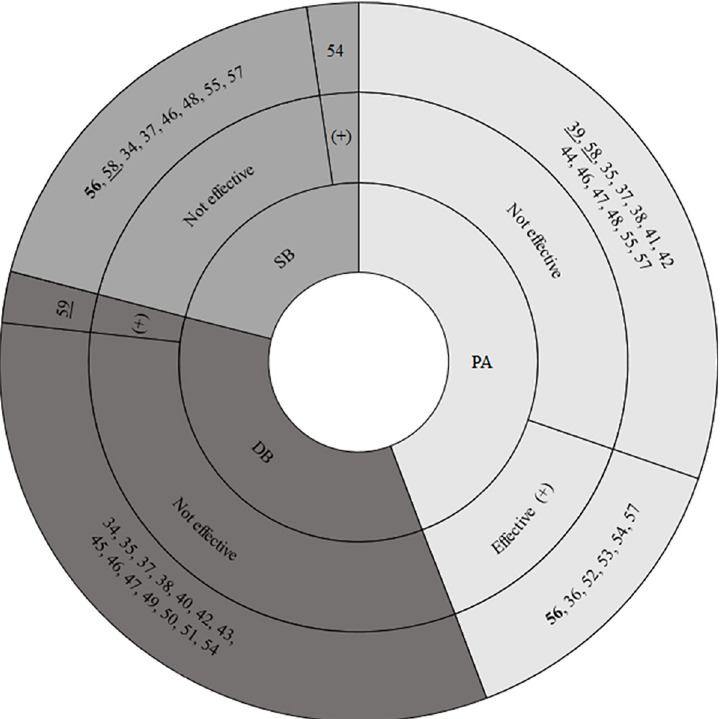
Fig 3. Effectiveness of included studies in improving sedentary behavior, physical activity or dietary behavior. DB = dietary behavior, PA = physical activity, SB = sedentary behavior, (+) = study effective in improving the behavior. Bold number = high quality score, underscored number = moderate quality score, other numbers = low quality score. Of study 57 the fundamental movement skills-component was effective in improving PA, the behavioral modification- component was